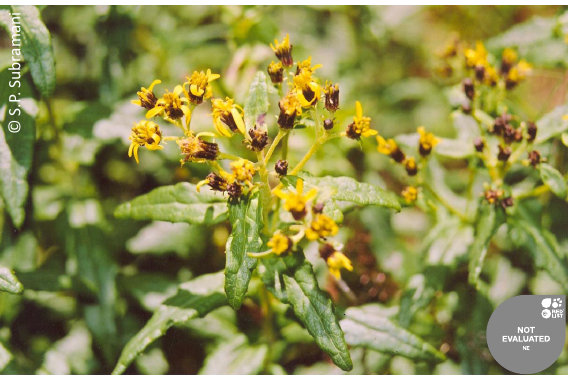
Image 8. Senecio kunthianus Wall. ex DC.